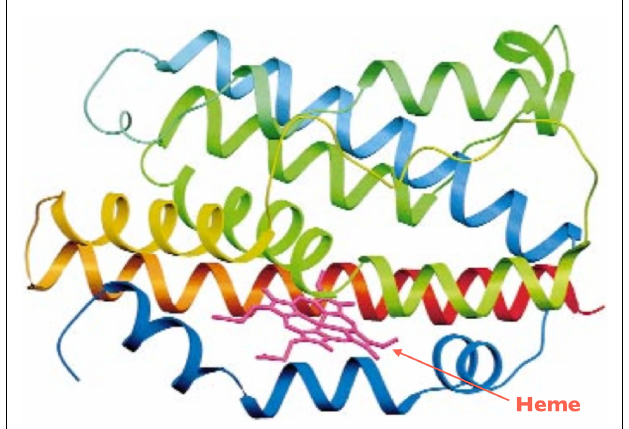
FIGURE 2 | Ribbon diagram of HO-1. The N-terminus is blue and the C-terminus is red, with green in the middle. Heme is shown by the arrow. Adapted from Schuller et al.